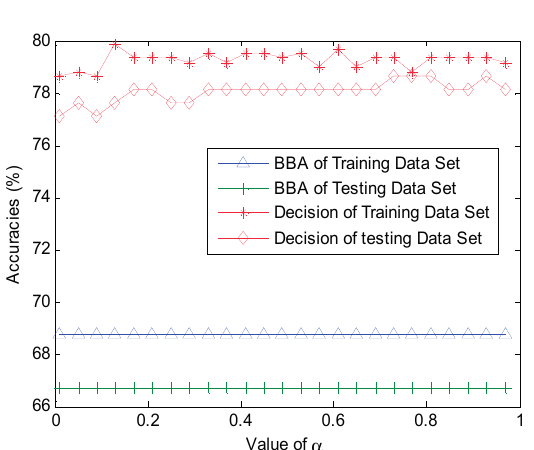
Figure 5. Accuracies with different (cid:2009)